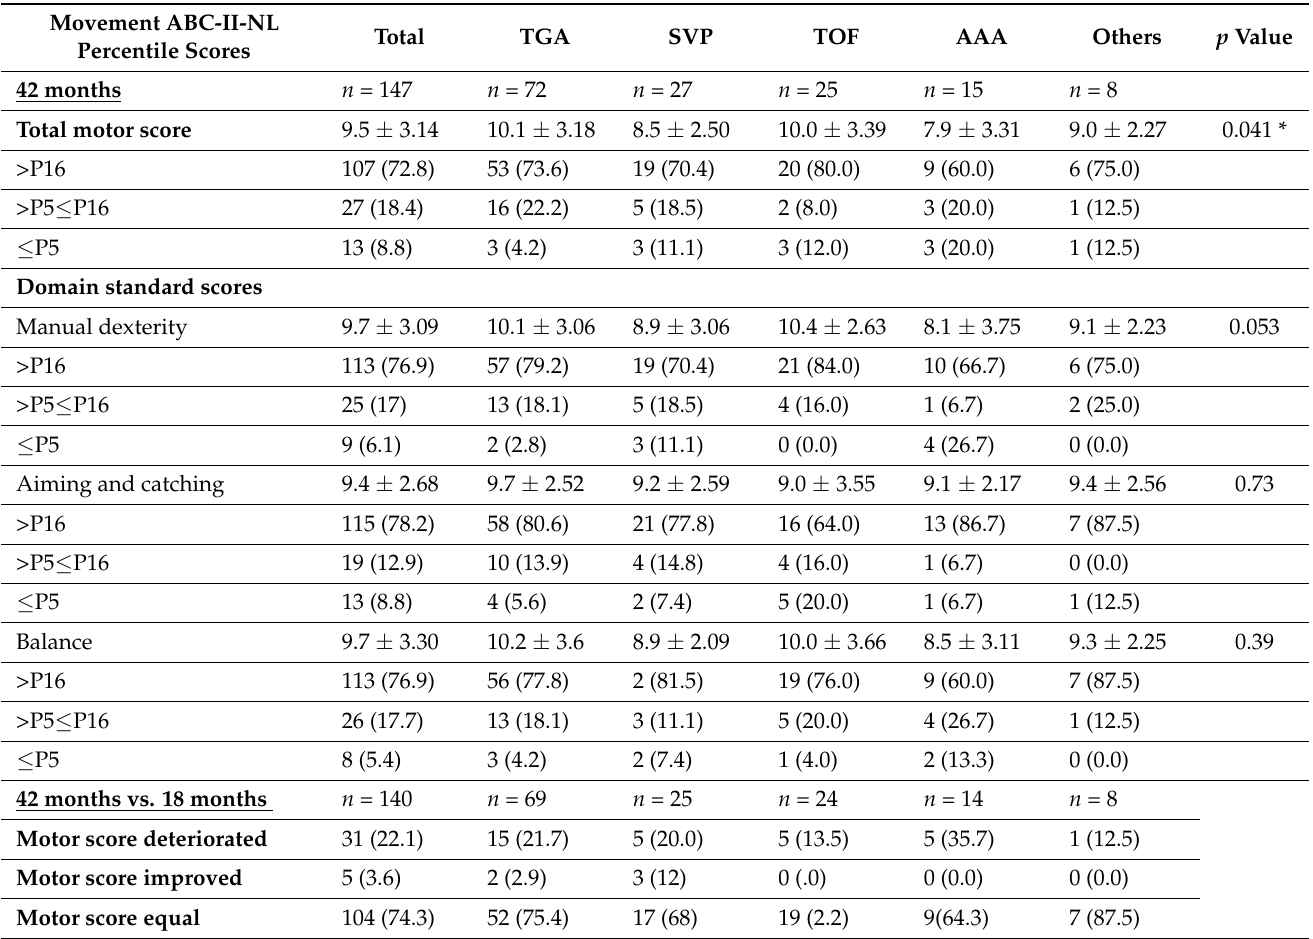
Table 2. Movement Assessment Battery for children–II-NL: Motor outcomes of preschoolers with a critical congenital heart defect